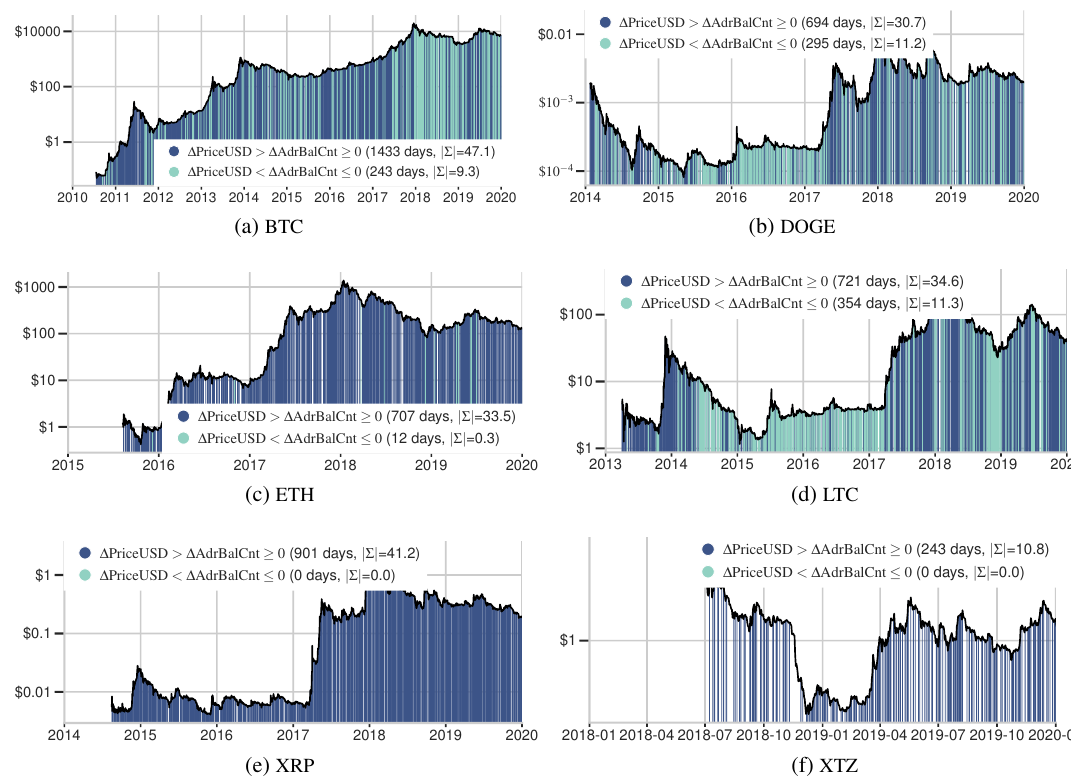
Fig. 2. Network effect observations and distribution (blue: positive NFX, green: reverse NFX, white: no NFX); userbase measured by total addresses with non-zero balance, value measured by USD token